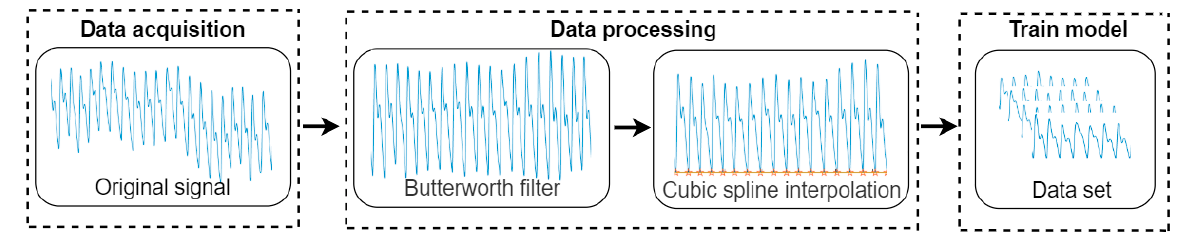
Figure 4. Data processing fl ow chart.